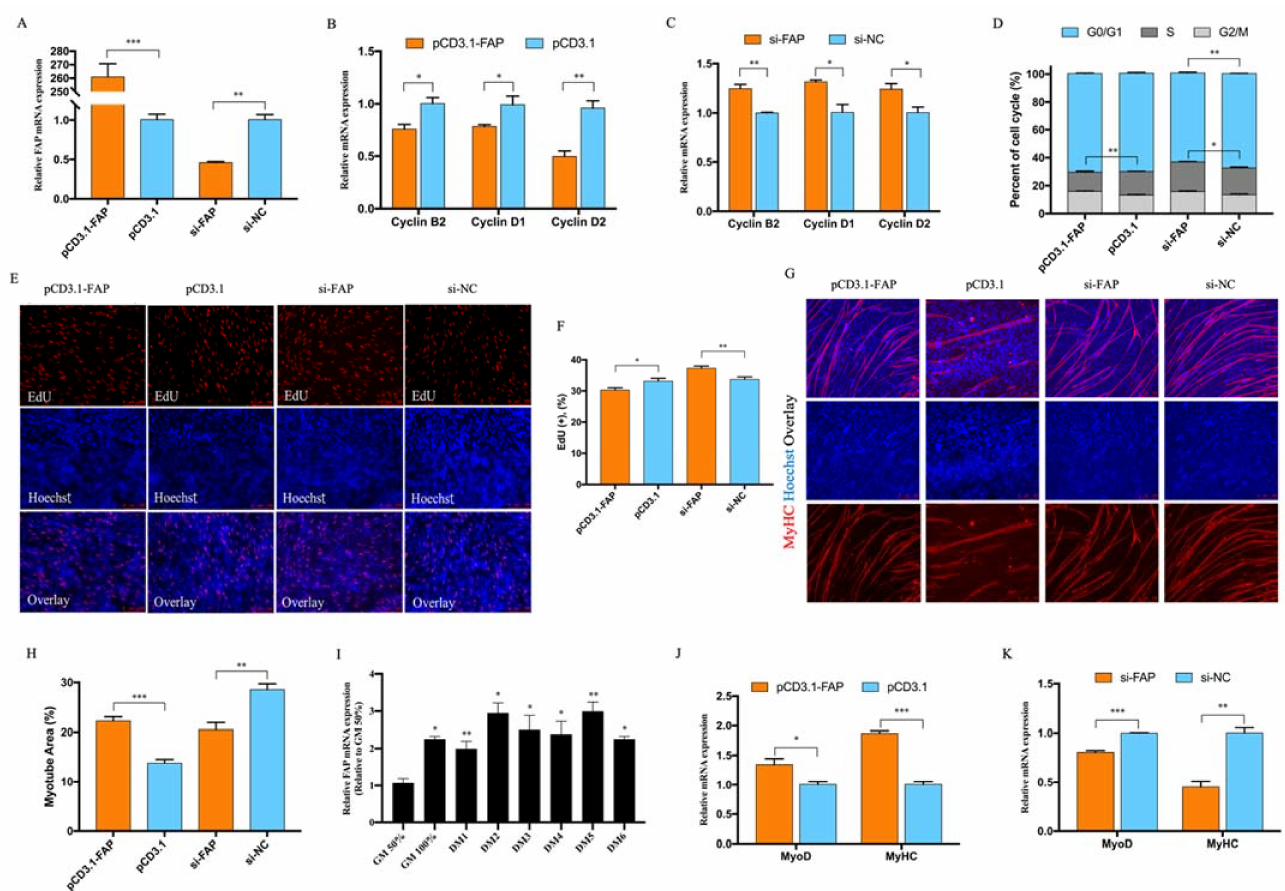
Figure 4. FAP inhibited myoblast proliferation and promote myoblast differentiation. ( A ) FAP successfully overexpressed and inhibited in myoblast after transfected with pCD3.1-FAP and si- FAP. ( B , C ) qRT-PCR results of Cyclin B2, Cyclin D1, and Cyclin D2 after FAP overexpression and knockdown. ( D ) Cell cycle analysis after FAP overexpression and knockdown. ( E , F ) EdU staining and positive EdU cell rate for myoblast cell after FAP transfection. ( G , H ) MyHC immunofluorescence staining of myotube and myotube area percentage after miR-144-5p transfection. ( I ) The relative expression of FAP during myoblast differentiation. ( J , K ) qRT-PCR results of MyoD and MyHC after FAP transfection. (* p < 0.05; ** p < 0.01, *** p <